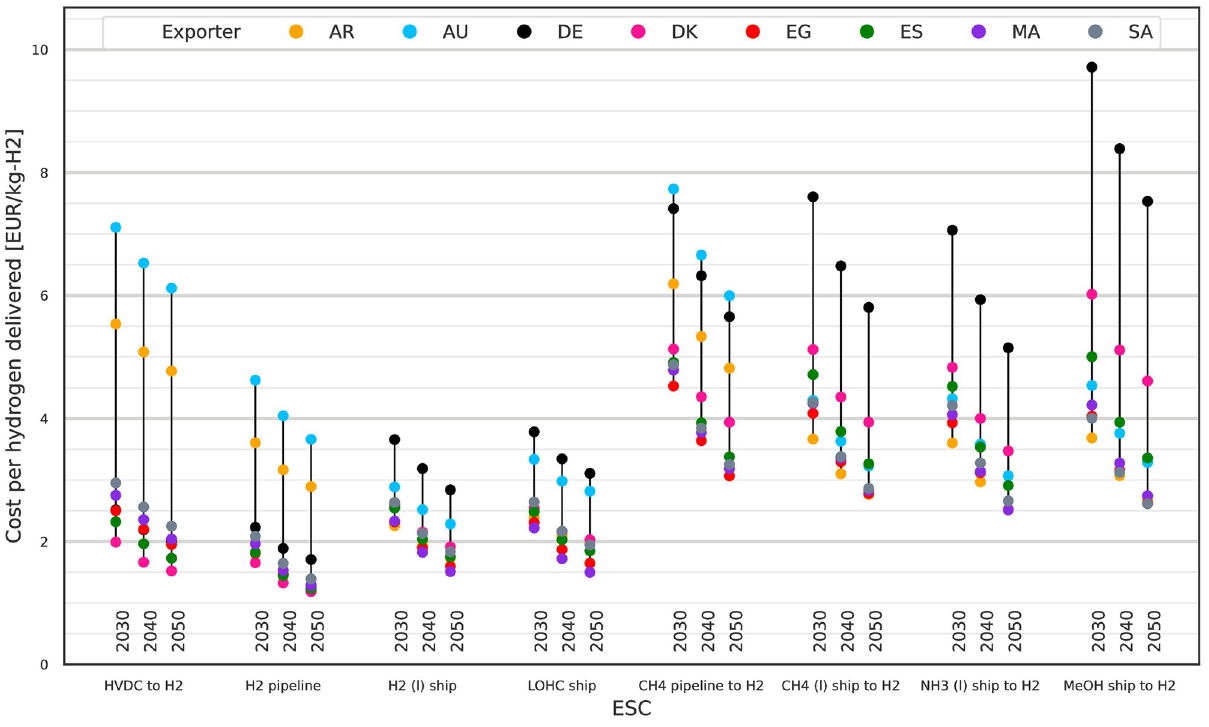
Fig 10. LCoH for 2030 to 2050 at a reduced WACC of 5% p.a.. Lowering the WACC reduces LCoH by around 35%.